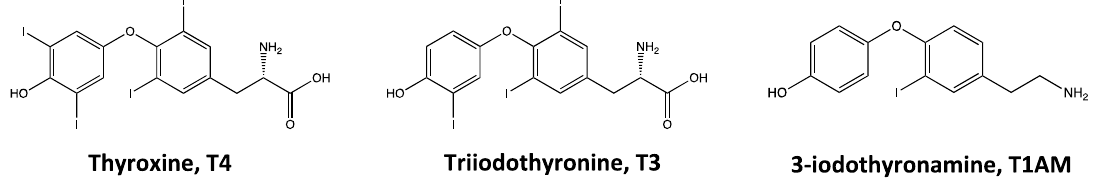
Figure 1. Structures of thyroid hormones (thyroxine, T4, and triiodothyronine, T3) and their putative derivative 3-iodothyronamine (T1AM).